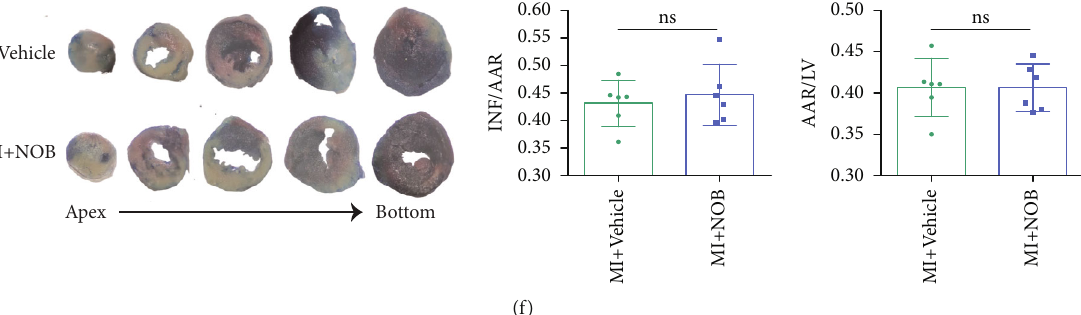
Figure 1: NOB protects against CHF after MI. (a) The chemical structure of NOB. (b) The survival curve showed that NOB intervention improved the survival rate of mice after MI. The numbers of mice for the sham+vehicle, sham+NOB, MI+vehicle, and MI+NOB were 7, 8, 12, and 12 at the start of the experiment and after 3 weeks, and the numbers were 7, 8, 6, and 8, respectively. Six mice were sacri fi ced in the MI+vehicle group, and four were sacri fi ced in the MI+NOB group. The survival rates for each group were 100%, 100%, 50%, and 66.7%, respectively. (c) Representative echocardiography images for each group revealed that NOB alleviated the deterioration of cardiac function after MI ( n = 7 , 8, 6, and 8). (d) The cardiac parameters LVEF, LVFS, LVIDs, and LVIDd illustrated the protection of NOB against chronic heart failure after MI ( n = 7 , 8, 6, and 8). (e) The heart weight to body weight ratio decreased after NOB intervention compared with that in the MI group ( n = 7 , 8, 6, and 8). (f) Mice were administrated with NOB or vehicle for 3 days after MI surgery, and Evans blue and TTC staining was performed to identify whether NOB protects against acute heart failure after MI. The results showed no di ff erences between the INF/AAR (infarct area/area at risk) and AAR/LV (area at risk/whole left ventricle area) ratios between the MI +vehicle and MI+NOB groups, indicating that NOB administration could not protect mice after acute MI (the white area indicates the infarct area, the red area shows ischemia, and the blue area indicates normal cardiac tissue) ( n = 6 and 6). Data are presented as mean ± SD . ∗∗ P < 0 : 01 ; ∗∗∗ P < 0 : 001 ; ns P > 0 : 05 . NOB: nobiletin; MI: myocardial infarction; EF: ejection fraction; FS: fractional shortening; LVIDd: left ventricular internal diameter at end diastole; LVIDs: left ventricular internal diameter at end systole; TTC: triphenyl tetrazolium